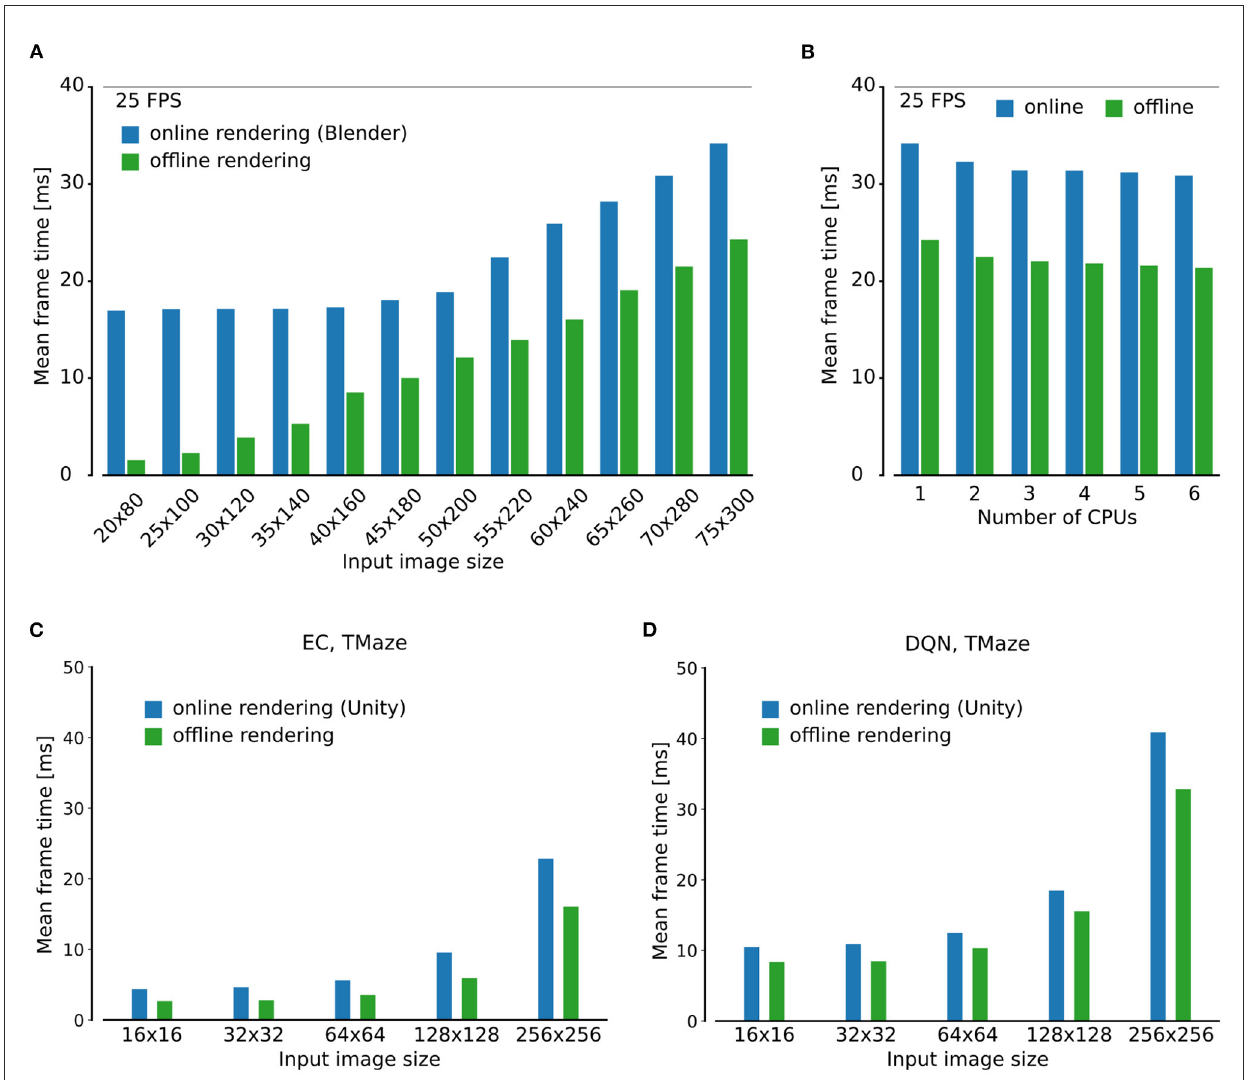
FIGURE4 Analysis of simulation speed. (A) Comparison of simulation time of a single step using the online and offline rendering method with Blender for observations of different size. (B) Scaling of run time with number of CPUs. (C, D) As in (A) but for the Unity rendering instead of Blender, using the MFEC (A) and DQN (B)